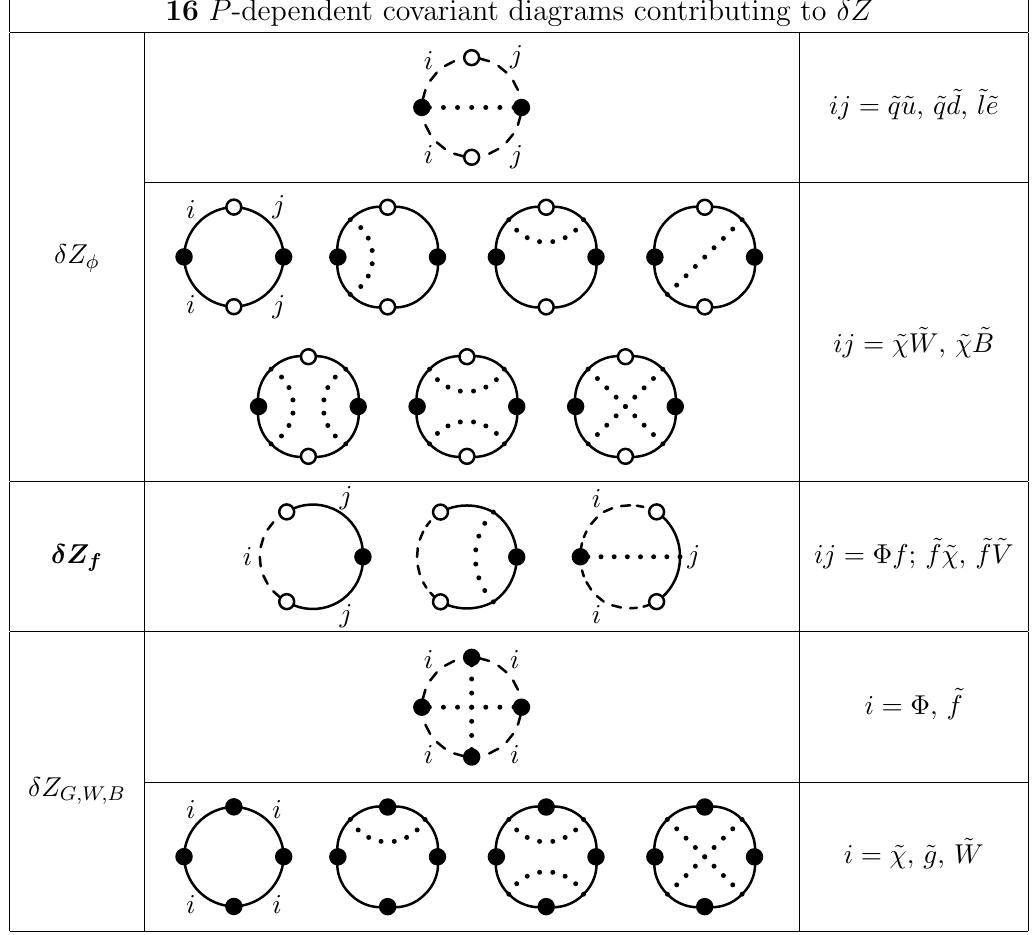
Table 7 . Covariant diagrams contributing to kinetic